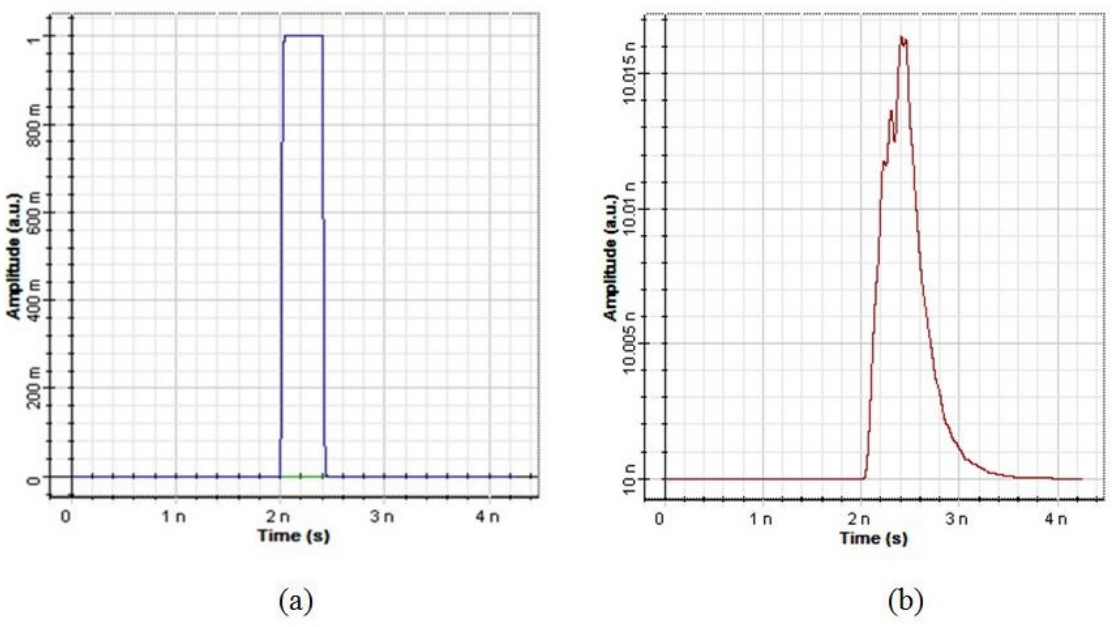
Figure 13. Simulation results from a dual LED NLOS propagation model. ( a ) Input signal. ( b ) Output